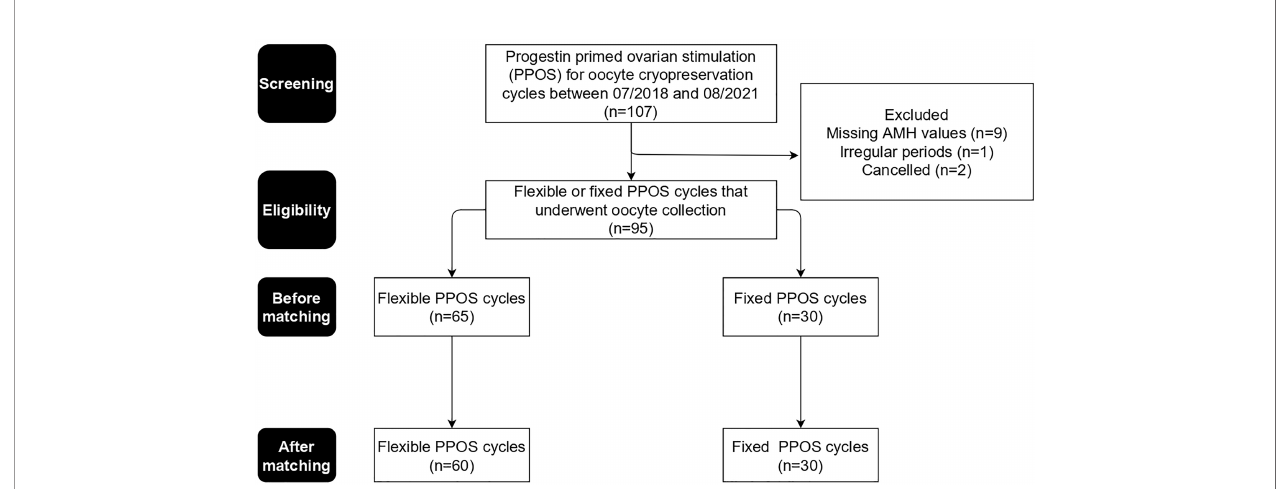
FIGURE 1 | Study enrolment